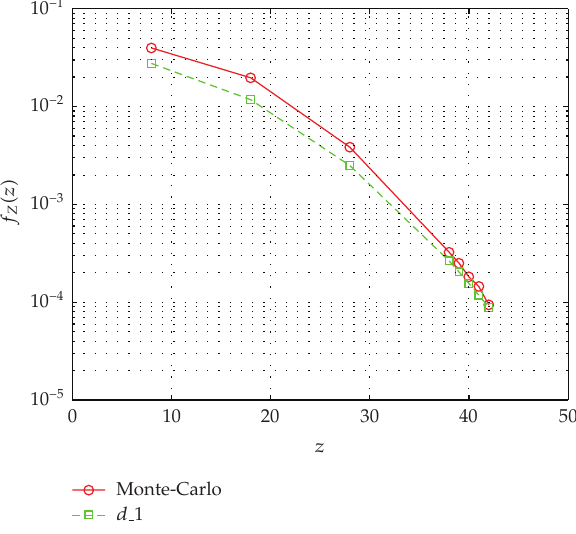
Figure 4: Right tail f Z ,ρ < σ 1 /σ 2 . d 1 is the